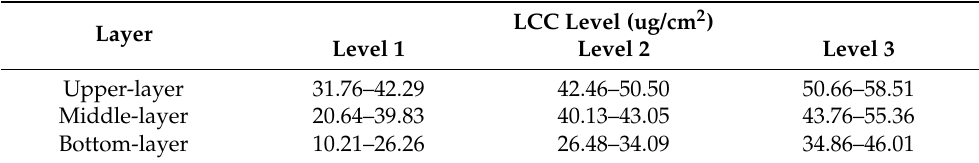
Table 4. Factor level of the leaf chlorophyll content in different